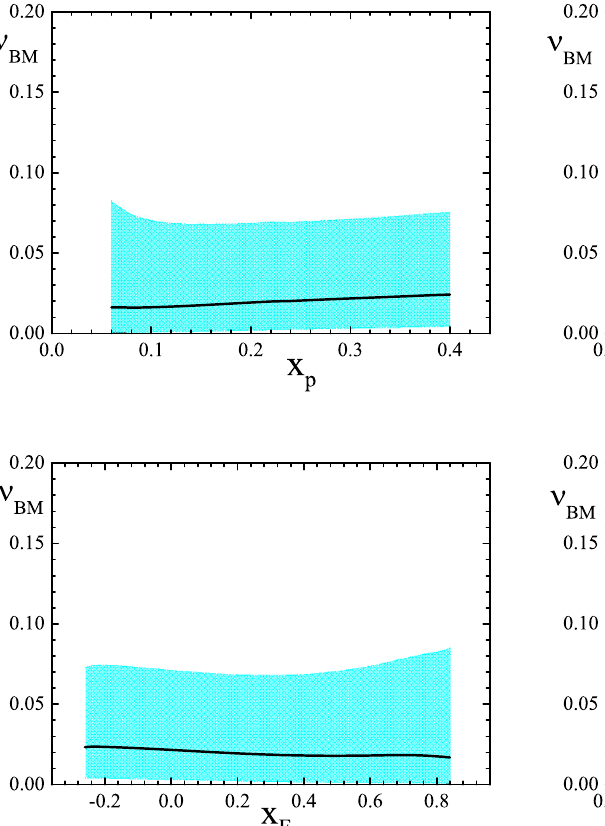
lution at the kinematics of COMPASS. The shadow areas correspond to the uncertainty of the parameters in the parametrization of the Boer- Mulders function for proton in Ref.